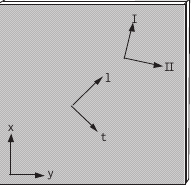
Fig. 1. Orthotropic material: transversal and longitudinal directions are indicated by letters “l” and “t”.